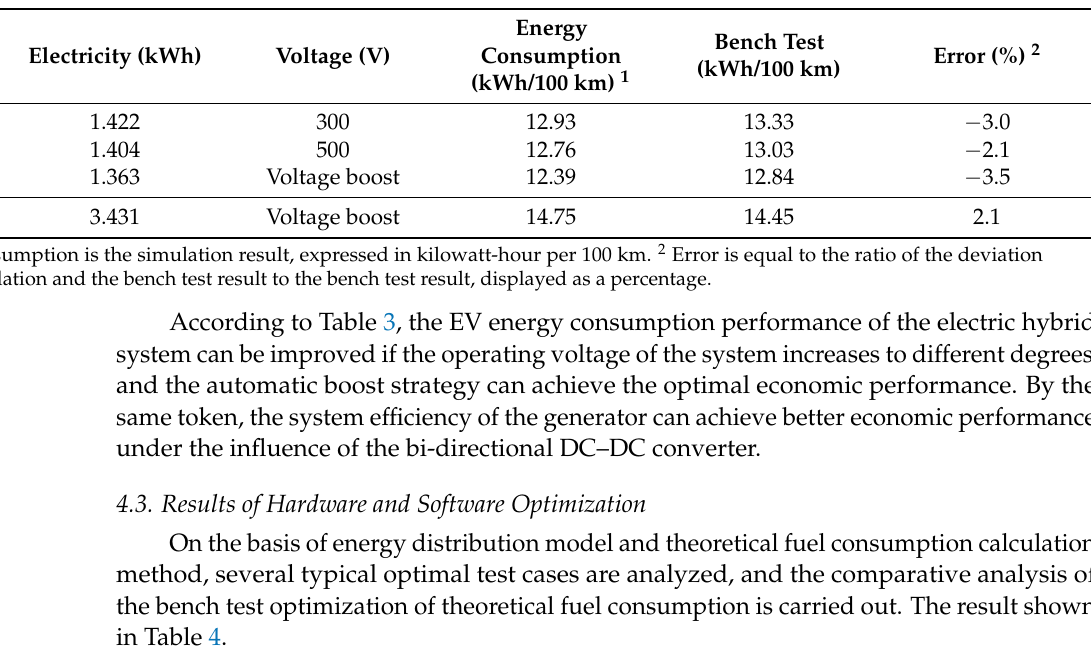
Table 3. Energy consumption performance of EV test.